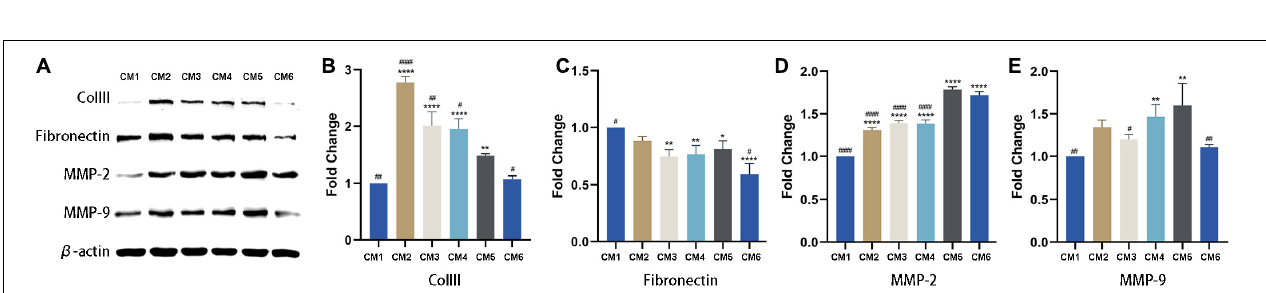
FIGURE 4 | Expression of ECM-related factors detected by western blotting. (A) COLIII, fibronectin, MMP-2 and MMP-9 levels were detected by western blotting. β -actin served as the loading control. (B,C) Quantitative analysis result of COLIII and fibronectin. With the increase of HGF concentration, their expressions decreased. (D,E) Quantitative analysis result of MMP-2 and MMP-9. They were upregulated following the applications of CMs. *, versus CM1. * means p < 0.05, ** means p < 0.01, **** means p < 0.0001. #, versus CM5. # means p < 0.05, ## means p < 0.01, #### means p < 0.0001.